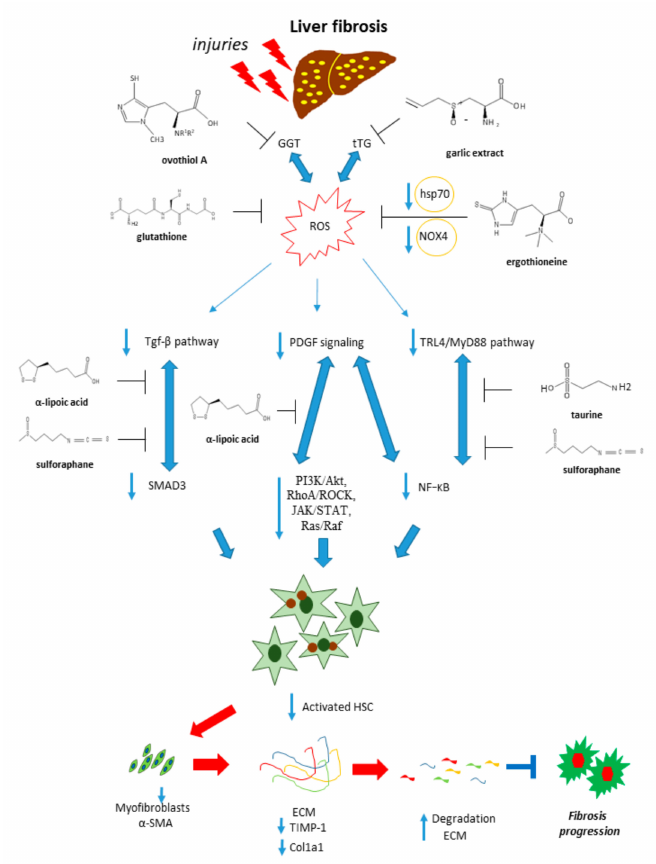
Figure 5. Antifibrotic properties of sulfur-containing compounds. Sulfur-containing compounds are able to interfere with molecular pathways associated with liver fibrosis, such as TGF- β , PDGF, and TLR4 / MyD88 signaling, leading to the inhibition of HSCs activation and the fibrogenesis